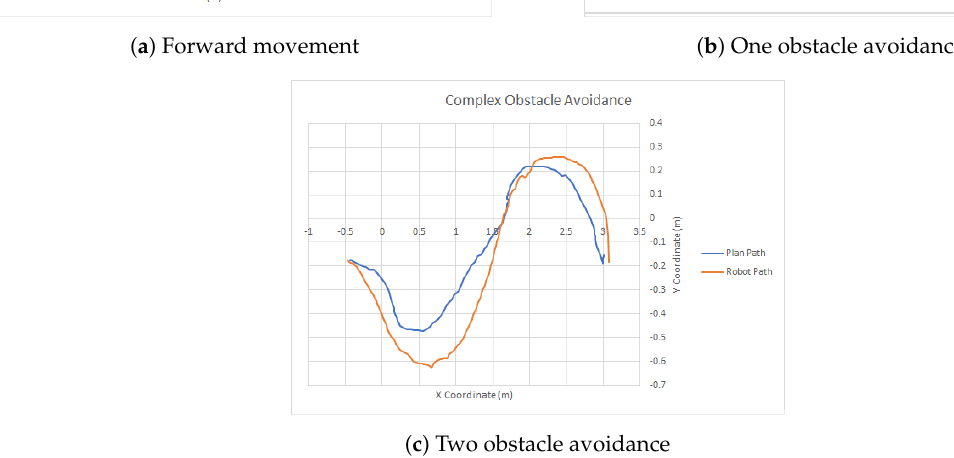
Figure 13. Navigation coordinate plots.